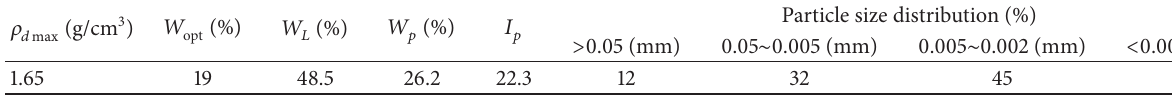
Table 1: The physical properties of the clay.